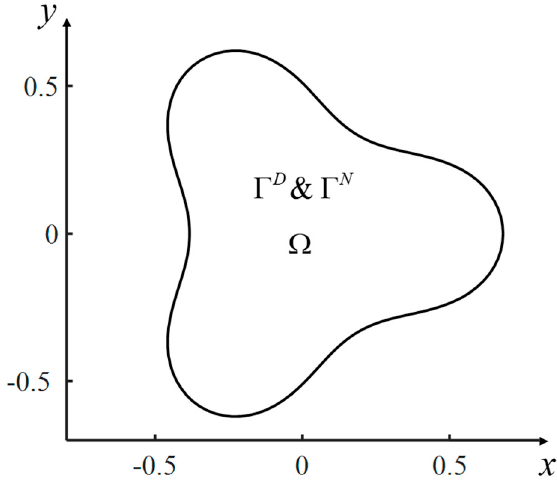
Figure 13. Schematic diagram of computational domain in case 6.